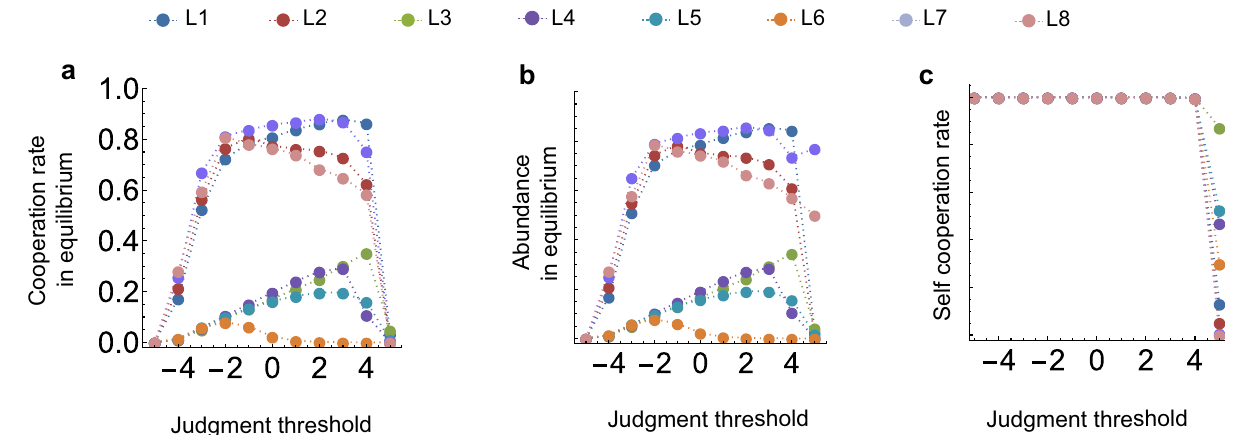
Fig.9|Varyingthethresholdforanoverallgoodreputationofplayers. Forthis fi gure,werepeattheevolutionarysimulationsshowninFig.5,andvarythethreshold S for an overall good judgment of a player. a , b We fi nd that cooperation rates and equilibrium abundance of the leading eight norms are not signi fi cantly different for threshold values between S = − 2 and S =4. Additionally, we observe that values of S